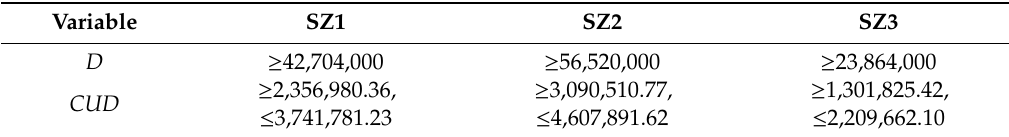
Table 8. Summary of bounds for D and CUD (m 3